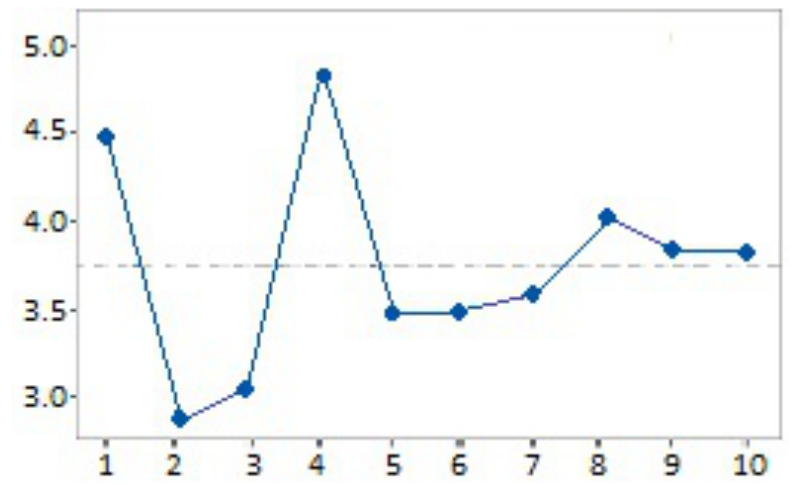
Figure 19. Main effects plot for judges’ evaluation.